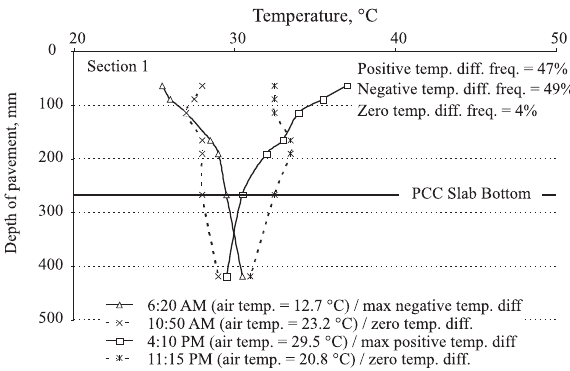
Fig. 4. Pavement temperature distributions with depth in 12 h aft er paving